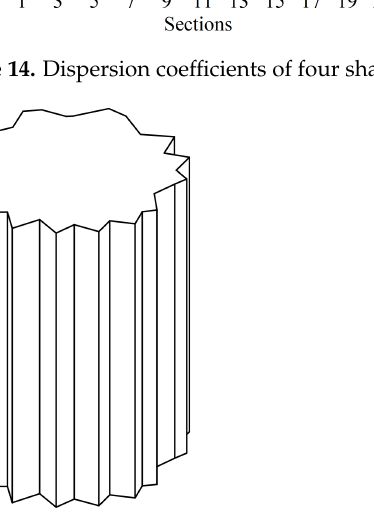
Figure 15. Schematic diagram of an ideal shaft constructed by single section. Table 2. Sections with similar roundness.